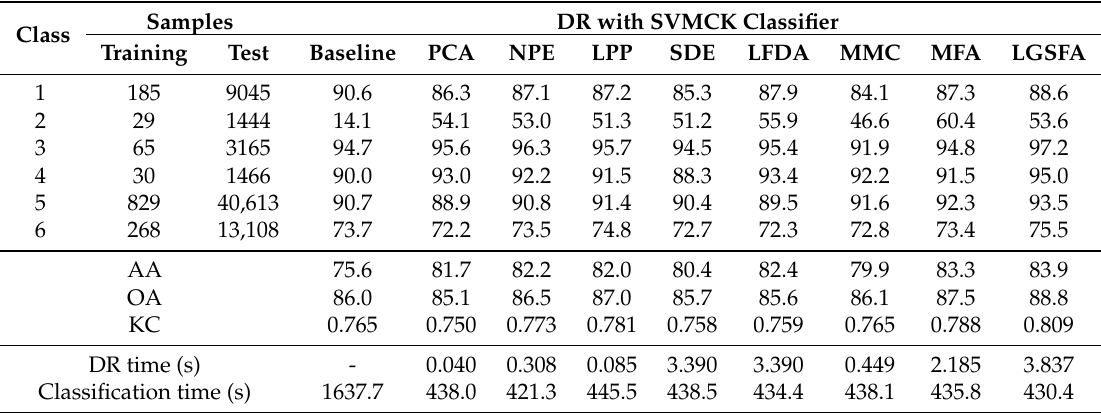
Table 6. Classification results of different DR methods with SVMCK on the Urban data